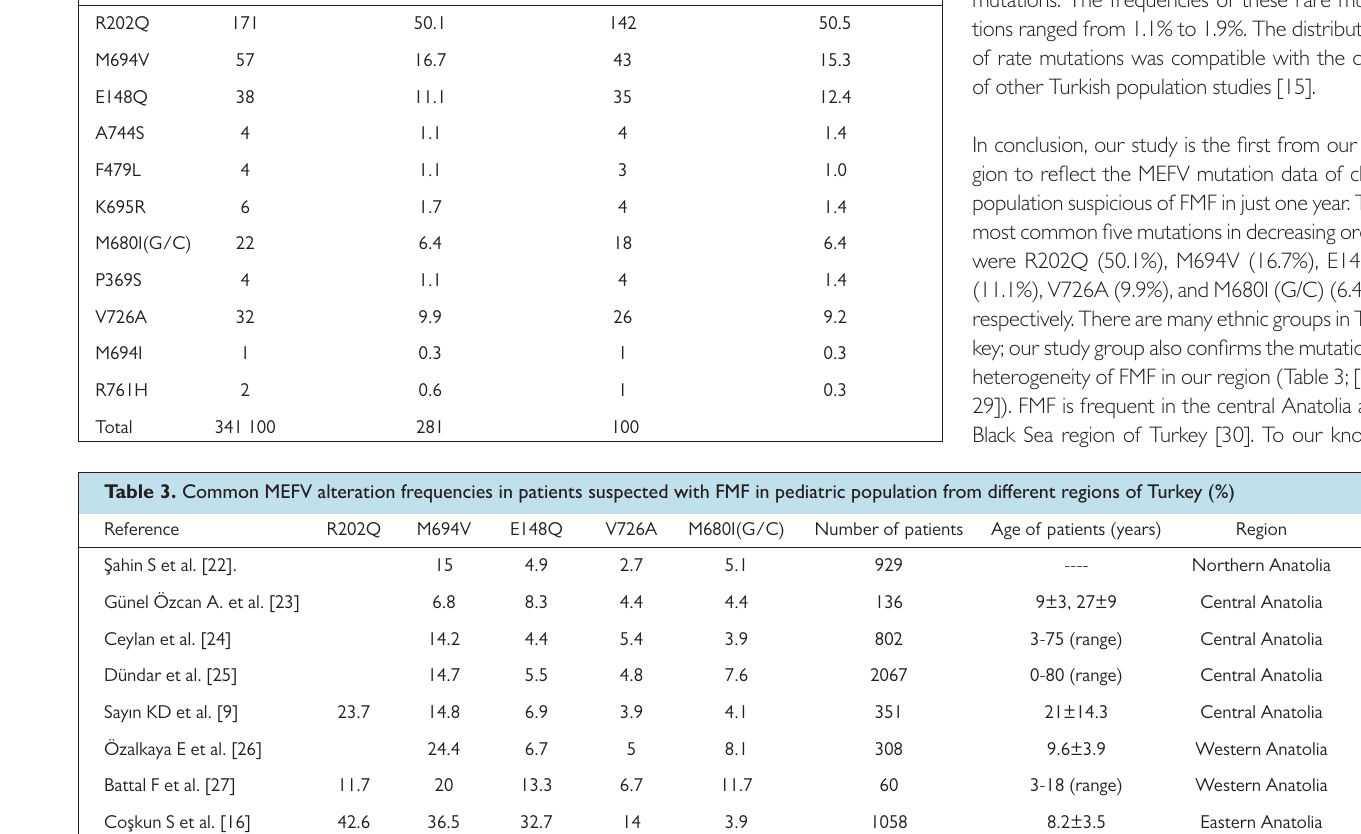
Table 2. Allele and mutation frequencies of MEFV mutations among mutant patients (n=213) Allele Number of alleles Allele frequency (%) Number of mutations Mutation frequency (%) R202Q